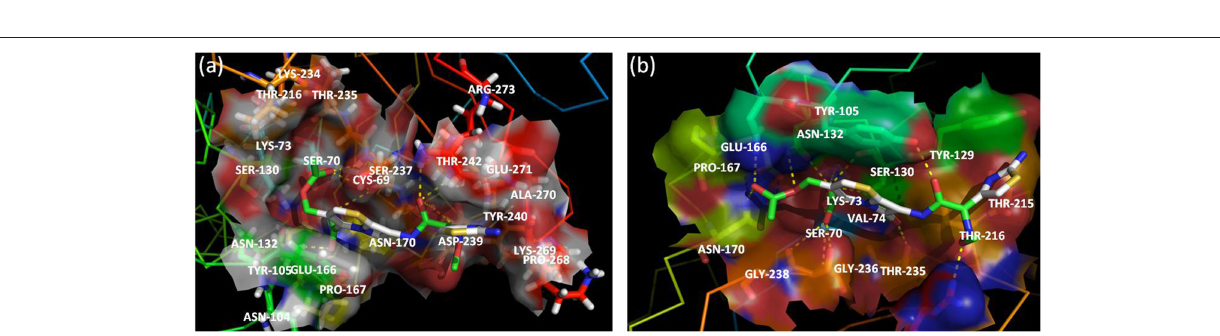
1997). In comparison to Asn270 residue of CTX-M-14